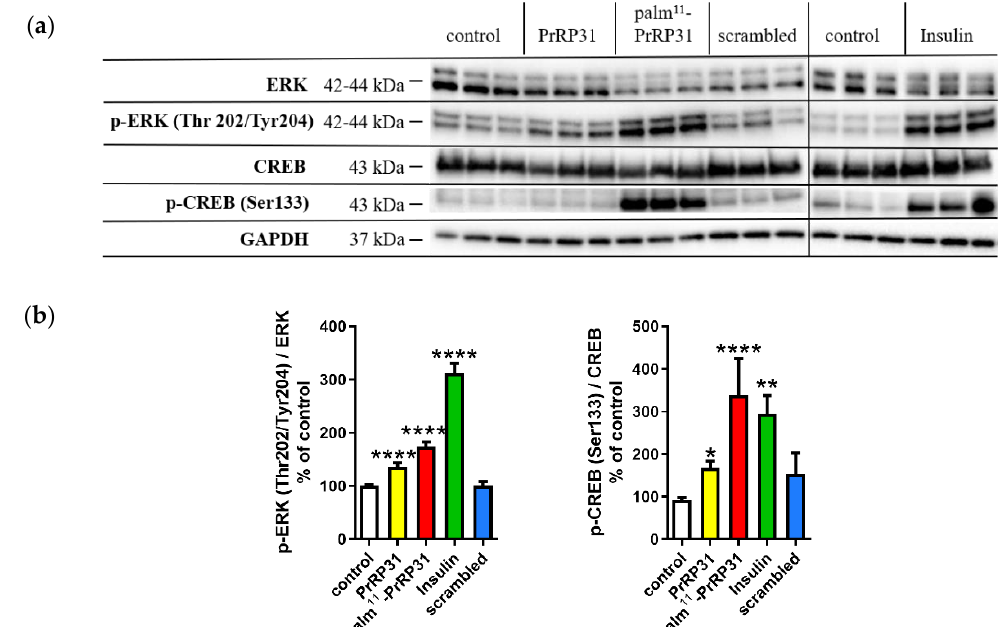
Figure 2. PrRP31 and palm 11 -PrRP31 increased phosphorylation of extracellular signal-regulated kinase / cAMP response element-binding protein (ERK-CREB) signaling pathway in SH-SY5Y cells. Immunoblots: ( a ) and their quantifications: ( b ). SH-SY5Y cells were incubated either with PrRP31 and its palmitoylated analog and scrambled at a final concentration 1 × 10 − 5 M, or with insulin at the final concentration 1 × 10 − 7 M at 37 ◦ C for 8 min, or medium alone. Activation was expressed as the ratio of the activated protein to the total amount of the protein, both normalized to loading control, GAPDH. Data are presented as the means ± SEM as a percentage of control cells treated with medium alone analyzed by one-way ANOVA followed by the Dunnett post hoc test, * p < 0.5, ** p < 0.01, **** p < 0.0001 ( n = 3, each sample in triplicates).